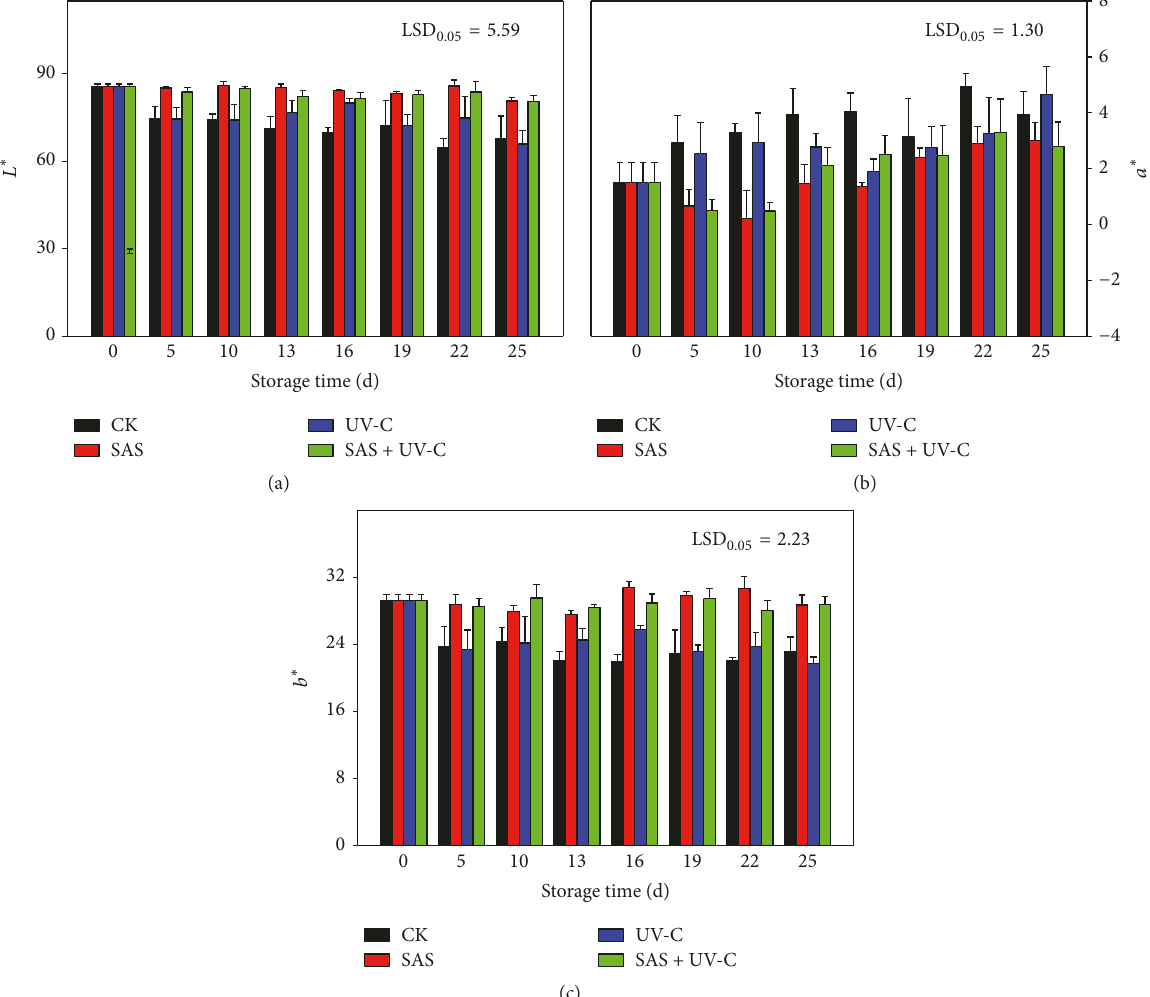
Figure 3: Effects of SAS, UV-C, and SAS + UV-C on color indexes of fresh-cut potatoes during storage. (a) 𝐿 ∗ value; (b) 𝑎 ∗ value; (c) 𝑏 ∗ value. The error bars represent the standard deviation. LSDs represent least significant differences at the 0.05